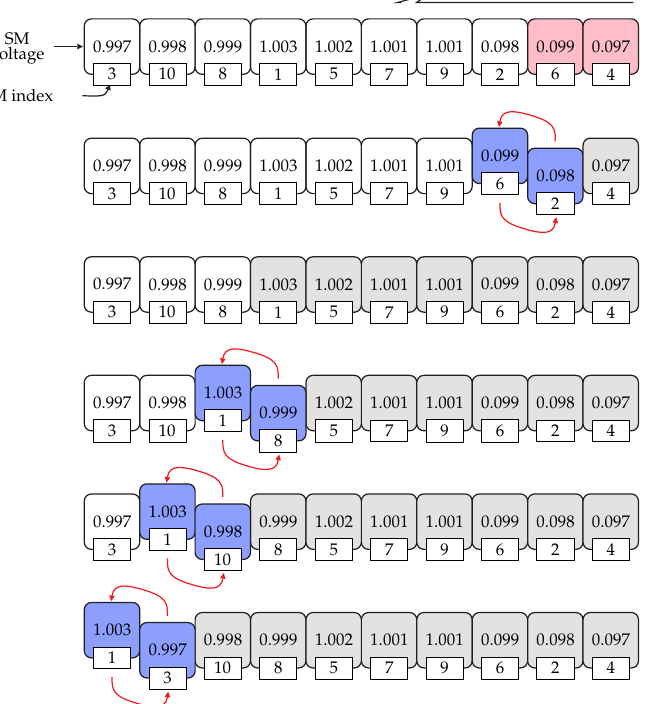
Figure 8. Submodule voltage sorting process.